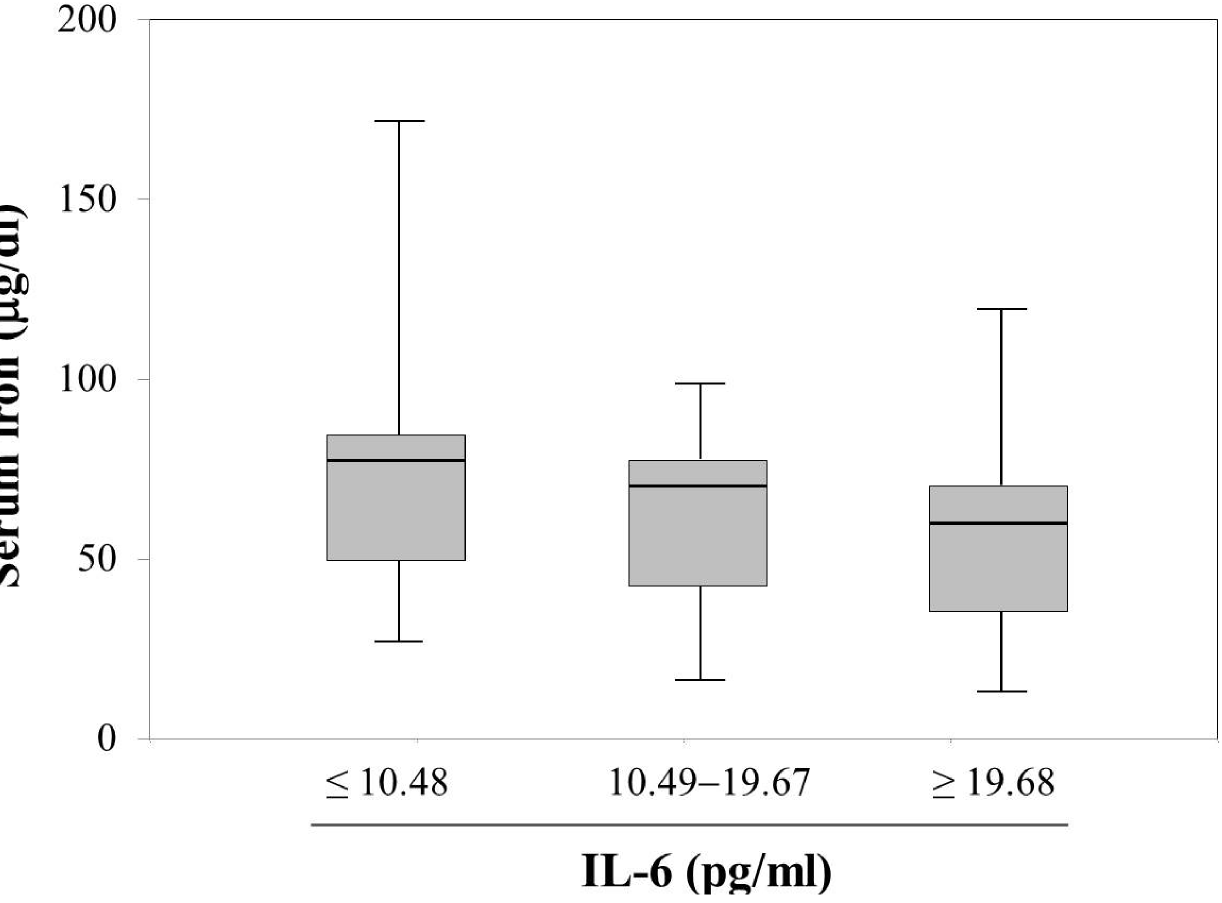
Figure 3. Trend analysis showed serum iron concentration was inversely proportional to IL-6 concentration in STEMI patients. AMI patients were divided into three subgroups according to circulating IL-6 concentration tertile: group 1, IL-6 concentration # 10.48 pg/ml (n=19); group 2, IL-6 concentration between 10.49–19.67 pg/ml (n=20); group 3, IL-6 concentration $ 19.68 pg/ml (n=16). Trend analysis showed serum iron concentration was inversely proportional to IL-6 concentration. (Jonckheere-Terpstra test, P =0.043).